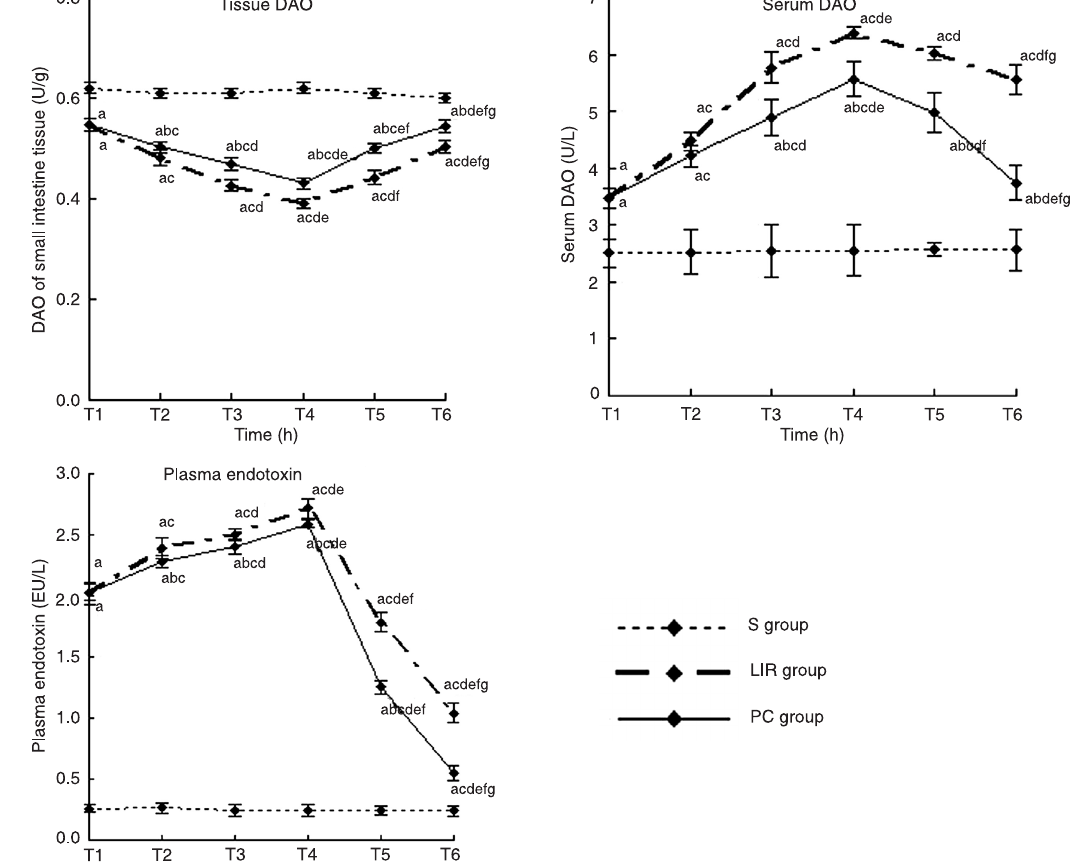
Figure 1. Effect of limb ischemia and reperfusion on intestinal tissue diamine oxidase (DAO), serum DAO and plasma endotoxin con- centrations in the rat. Group S: sham-operated group; group LIR: limb ischemia-reperfusion group, and group PC: post-conditioning group. Data are reported as means ± SD for 6 rats in each group. Reperfusion time: T1 = immediate (0 h); T2 = 1 h; T3 = 3 h; T4 = 6 h; T5 = 12 h, and T6 = 24 h. a P < 0.05 vs group S; b P < 0.05 vs group LIR; c P < 0.05 vs T1; d P < 0.05 vs T2; e P < 0.05 vs T3; f P < 0.05 vs T4; g P < 0.05 vs T5 (one-way ANOVA).